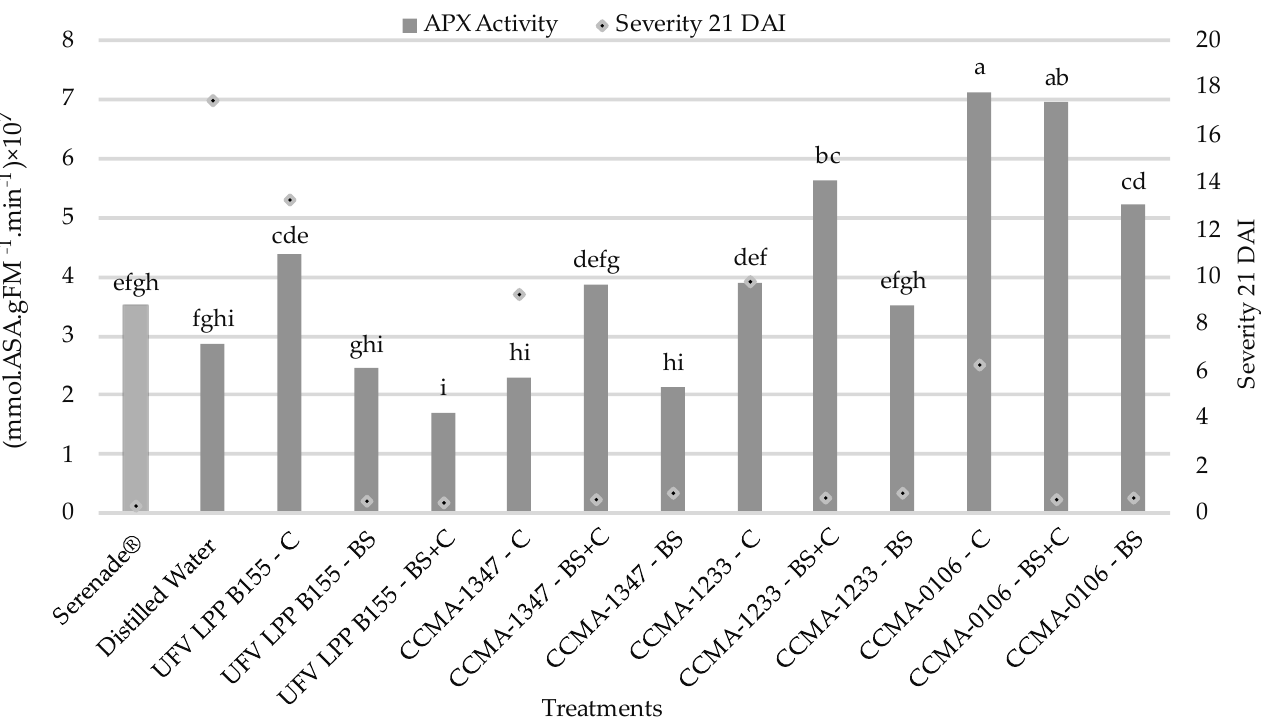
Figure 5. SOD Activity 21 days after pathogen inoculation. UFV LPP B155 and CCMA-1347 = B. subtilis ; CCMA-1233 = B. licheniformis ; CCMA-0106 = P. aeruginosa . BS: Biosurfactants; C: Bacterial cells; BS + C: Biosurfactants + Bacterial cells. Bars followed by the same letter do not differ from each other by Tukey ’ s test α = 0 .05. The primary Y-axis shows activity in U SOD.min . −1 .g.FM − 1 , and the secondary Y-axis shows severity, represented by the dark-colored dot.